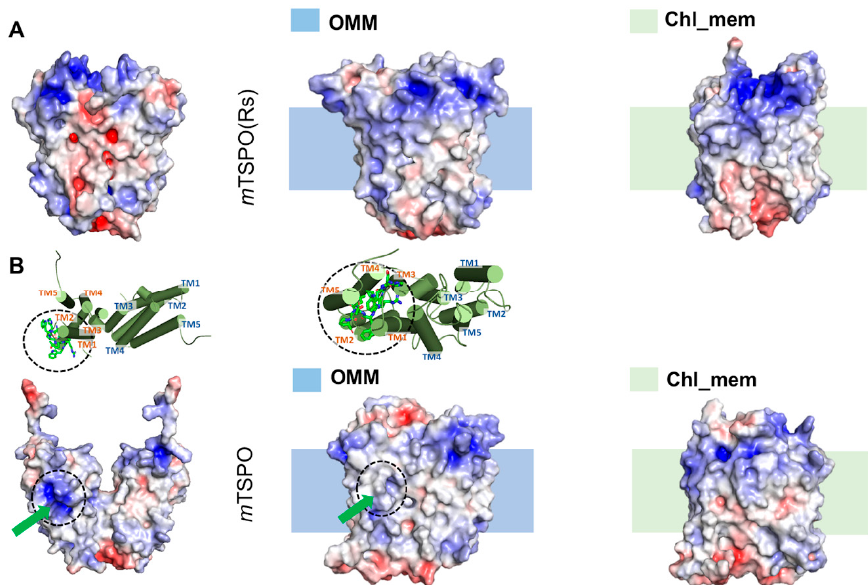
Figure 1. Electrostatic surface potential of the initial [28] and final molecular dynamics (MD) structures of ( A ) dimeric mouse TSPO model based on Rs TSPO dimer ( m TSPO(Rs)) and ( B ) dimeric mouse TSPO model based on NMR structure ( m TSPO) , in the different membrane environments simulated here . The initial structure is the one prior to the embedding in the model membranes and it is the first structure of each raw image. The shadow behind the second and the third structures of each column indicate the approximate location of the membrane. The upper part “insert” in B indicates how the exposed polar side-chains in m TSPO twist toward the bulk of the protein after the equilibration. The green arrows indicate the above-mentioned residues in the protein surface. The MD structures were backmapped to all-atom resolution using the backward.py script [31] . The red and blue surfaces represent negative and positive electrostatic potentials, respectively. The maximum values of the potentials are − 5 kT/e and +5kT/e, respectively (where k is Boltzmann constant, T is the temperature and e is the electric charge of an electron). Table 1. Residues of mouse TSPO located at the dimer interface identified experimentally [19] (left), an predicted by m TSPO (center) and m TSPO(Rs) structures at the end of the dynamics. Inferred by Region m TSPO Experiment